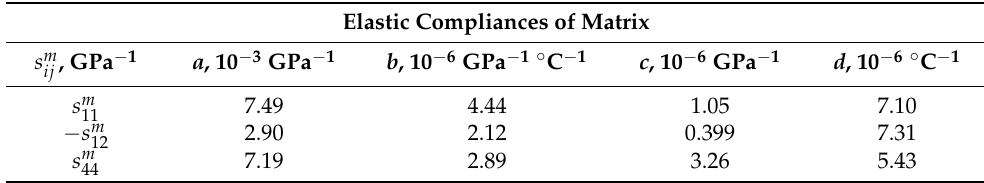
Table 4. Fitted parameters of Equation (11) for the γ -matrix. Elastic Compliances of Matrix